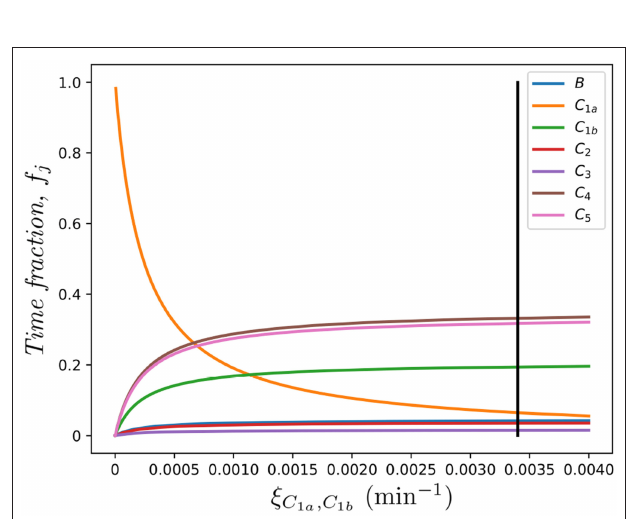
on the fraction of time spent FIGURE 8 | Effect of the migration rate ξ C 1 a , C 1 b in each compartment, f j , for j ∈ { B , C 1 a , C 1 b , C 2 , ... , C 5 } . The vertical black line represents the value ξ C in Table 1, as in Ganusov and Auerbach ( 1 a , C 1 b